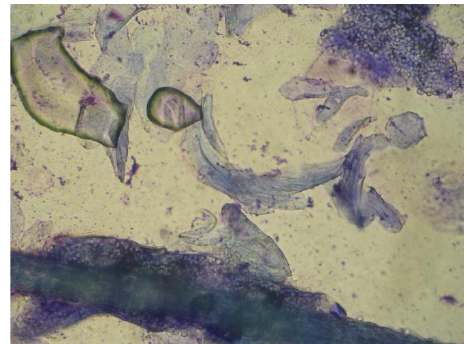
Figure 2. Adhesive tape impression cytology from a cat with dermatophytosis, showing an infected hair with hyphae surrounded by several spores and a cluster of spores on the background (40×).